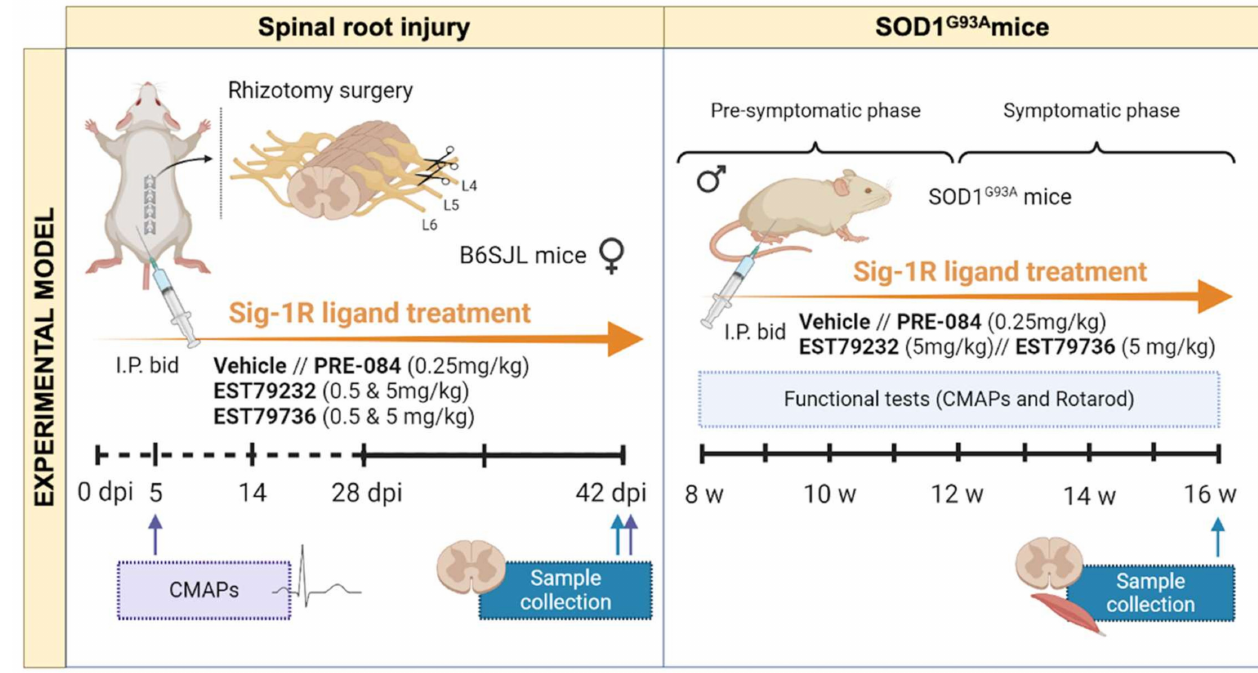
Figure 6. Schema of the in vivo studies. In the spinal root injury, treatment was given from the surgery until 42 days, when samples of the spinal cord were obtained. In the SOD1 G93A mice, EST79232 and EST79376 were given from 8 to 16 weeks of age. Electrophysiological and rotarod tests were performed periodically until 16 weeks, when samples of spinal cord and muscle were